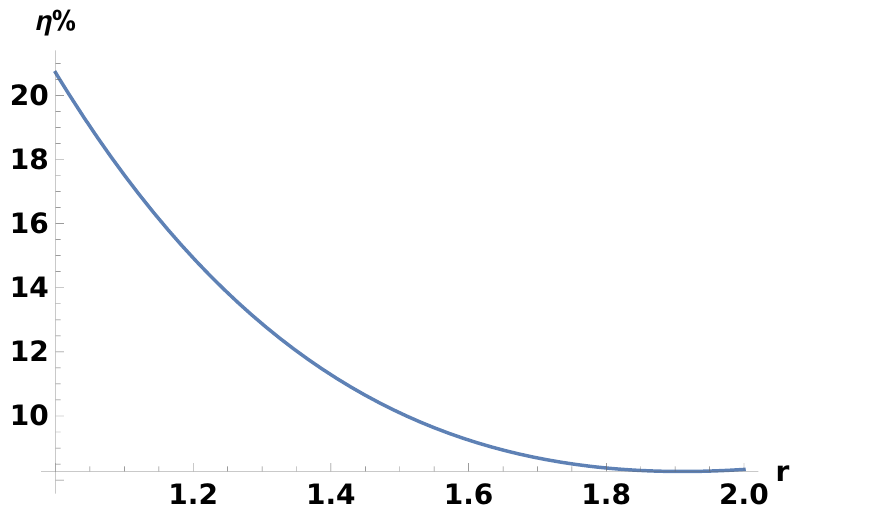
Figure 5. Change in efficiency as particle splitting or decay occurs away from the horizon. The pa- rameters are M = 1, l = 0, and a = 1. The radii of the event horizon and the ergoregion are 1 and 2,